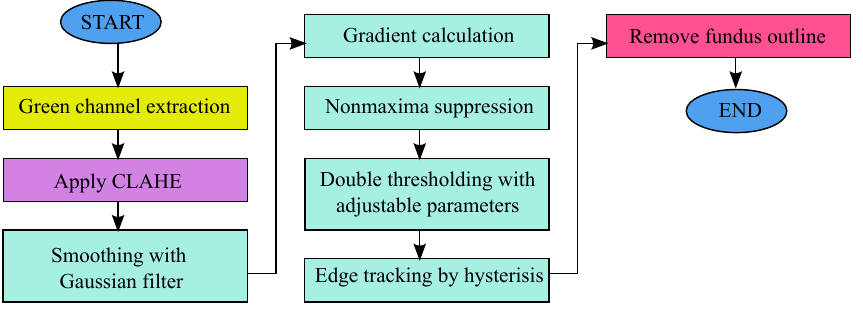
Figure 3. Flowchart of the modified edge